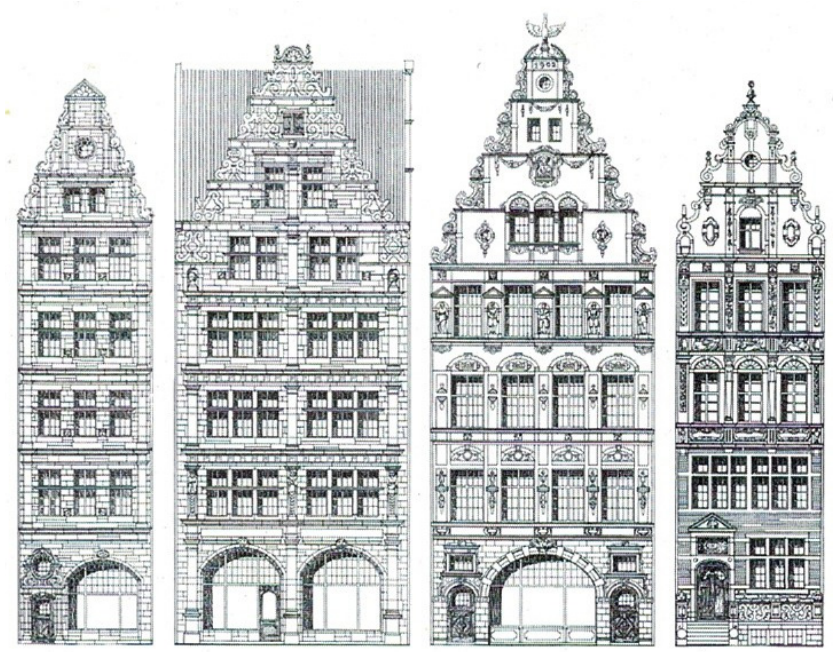
Figure 4. Tenement houses awarded in a competition for the facdes of buildings in Gda ń sk, 1902 [46].